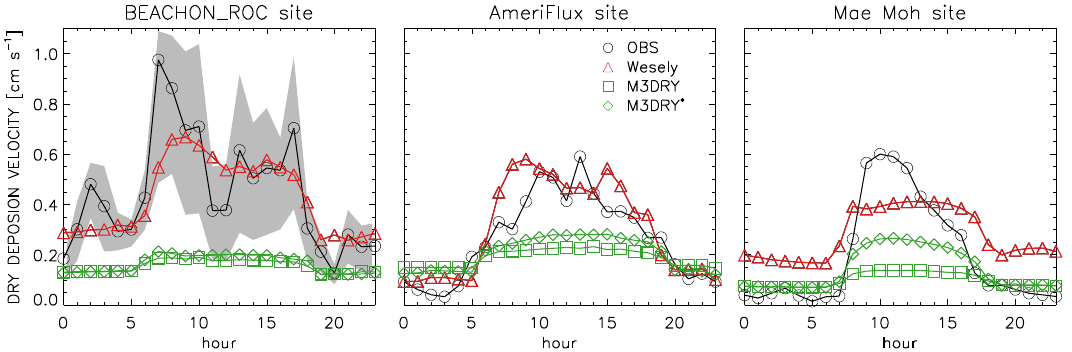
Figure 2. A comparison of the simulated and observed hourly mean O 3 dry deposition velocities from the BEACHON-ROCS campaign at the Manitou forest observatory for 7–31 August 2010 (left panel), at the Niwot Ridge AmeriFlux site in the Roosevelt National Forest in the Rocky Mountains of Colorado for 21–31 May 2005 (middle panel) in the United States, and at Mae Moh site in northern Thailand for January–April 2002 (right panel). The circles show observed values. The triangles, squares, and diamonds show the simulated values using the Wesely, the M3DRY with standalone stomata resistance, and the M3DRY with stomata resistance of the Pleim-Xiu land surface model, respectively. The shaded area indicates the observed dry deposition velocity range for the various zero-plane displacement heights ( d 0 ) in Eq. 4 from the BEACHON-ROCS